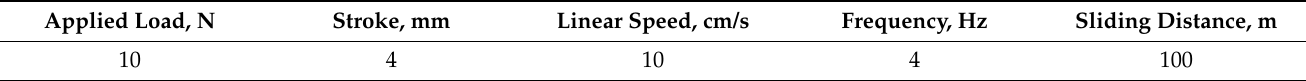
Table 4. UNSM treatment